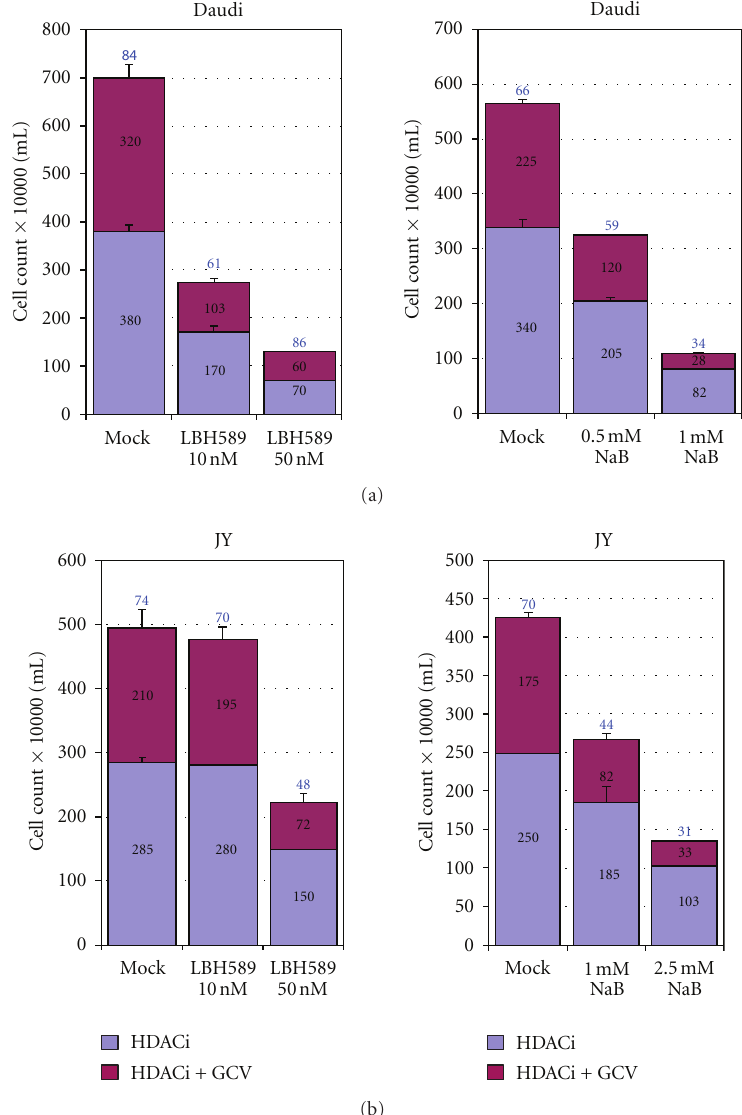
Figure 3: E ff ect of HDACi and GCV combination treatment on other EBV-positive lymphoma cells. (a) E ff ect of combination treatment on the BL line Daudi. Four hundred thousand cells per ml per well were cultured with 60 μ M GCV in the appropriate wells. Assay parameters were as described in the legend to Figure 2. (b) E ff ect of combination treatment on the EBV-transformed lymphoblastoid cell line JY. In this case, 200,000 cells per well were plated in the presence of 60 μ M GCV, or vehicle, as indicated. Experiments were repeated a minimum of three times and error bars represent standard